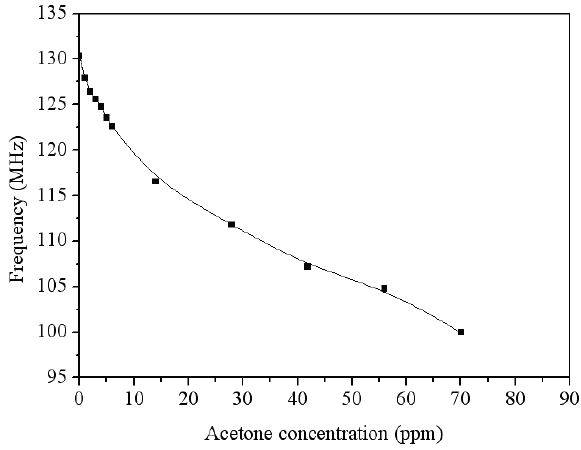
Figure 15. Output frequency of the acetone sensor with the oscillator circuit.